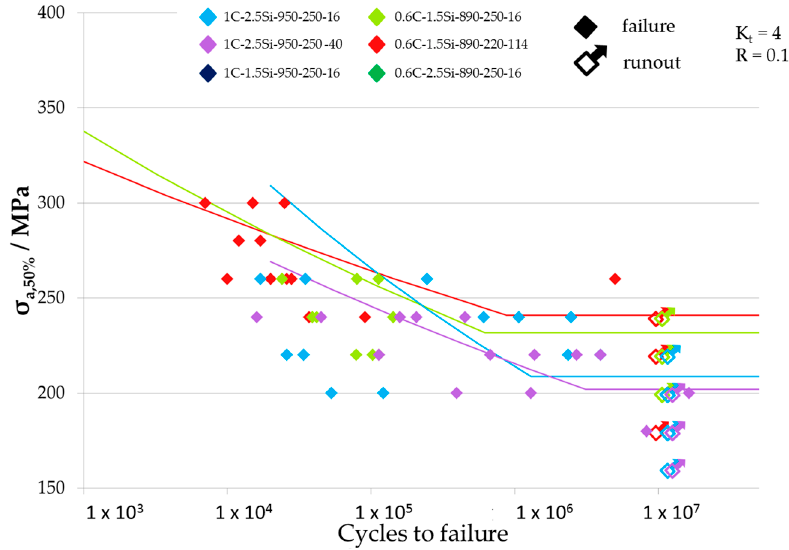
Figure 8. Woehler curves of the variants tested at specimens with K t = 4 and a load ratio R = 0.1.